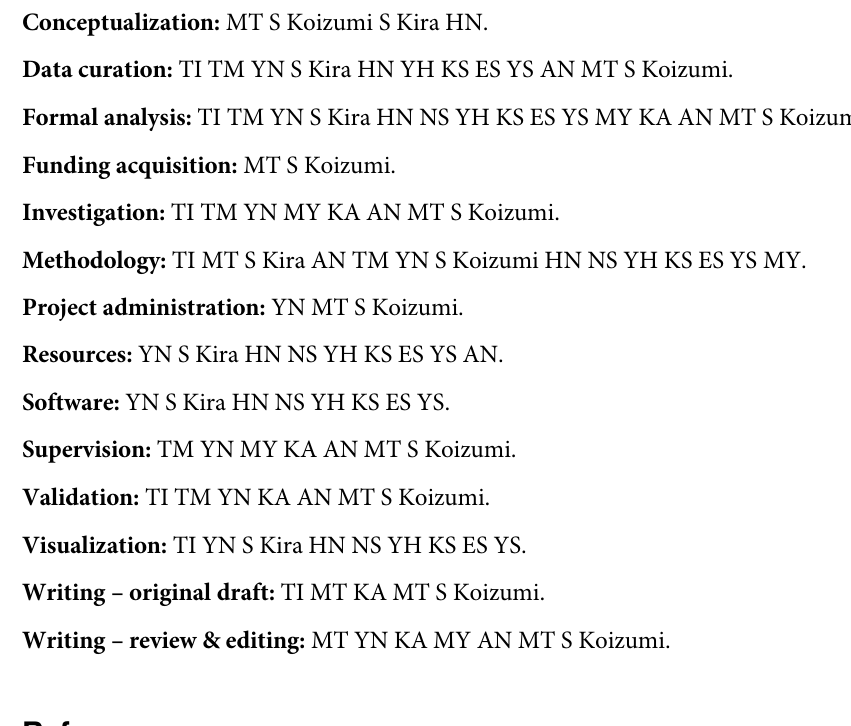
analyses were performed using a two-way ANOVA and Bonferroni’s test in order to compare differences of absolute mRNA level between WT and Clock Δ 19/ Δ 19 mice at each time point.